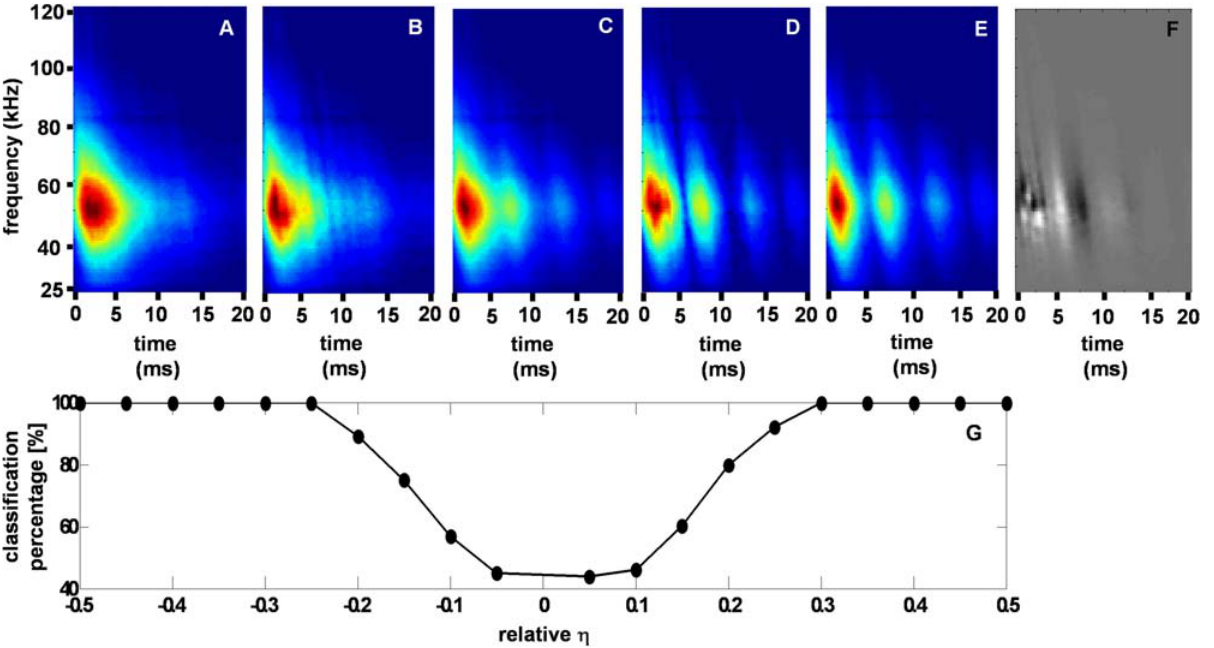
Figure 3. The results of generating hybrid sepctrograms of apple and corn. Only (B) and (D) were artificially generated. Color bars are not presented, but the data are in the spectral power scale. (A) Average spectrogram of apple. (B) The decision echo multiplied by g =0.07 added to the average spectrogram. (C) The average spectrogram of corn and apple. (D) Same as B, but with g = 2 0.07. (E) Average spectrogram of corn. (F) The decision echo calculated for this task used to create (B) and (D). Dark intensities depict negative values, while white depict positive ones. (G) Classification performance of echoes created from artificial hybridized spectrograms as a function of the g factor. To measure performance we divided the spectrograms of each species into 10 groups, each containing 50 spectrograms with a similar g . The units of g are relative, such that g =1 corresponds to an artificial spectrogram that is as distant to the hyperplane as the most distant original spectrogram. The performance is measured in the percentages of echoes that were correctly classified according to the expected classification.